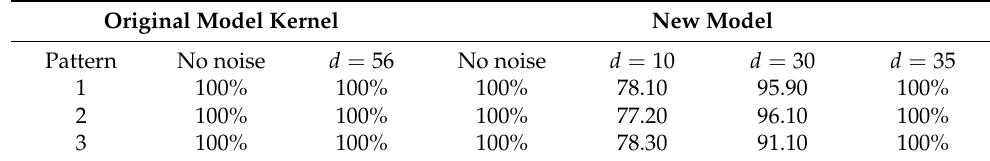
Table 10. Performance of the proposed model vs original model in 120 × 120 grayscale images. Original Model Kernel New